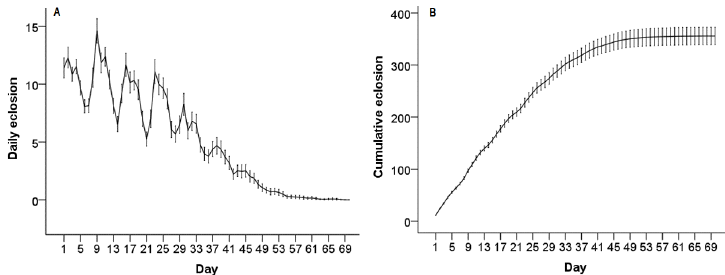
Fig 3. Daily eclosion rates. (A) Mean daily eclosion, measured as the total number of offspring eclosing on each day. (B) Mean cumulative eclosion per day. ‘ Day 1 ’ is the first day that offspring eclosed. Error bars represent the 95% CI.